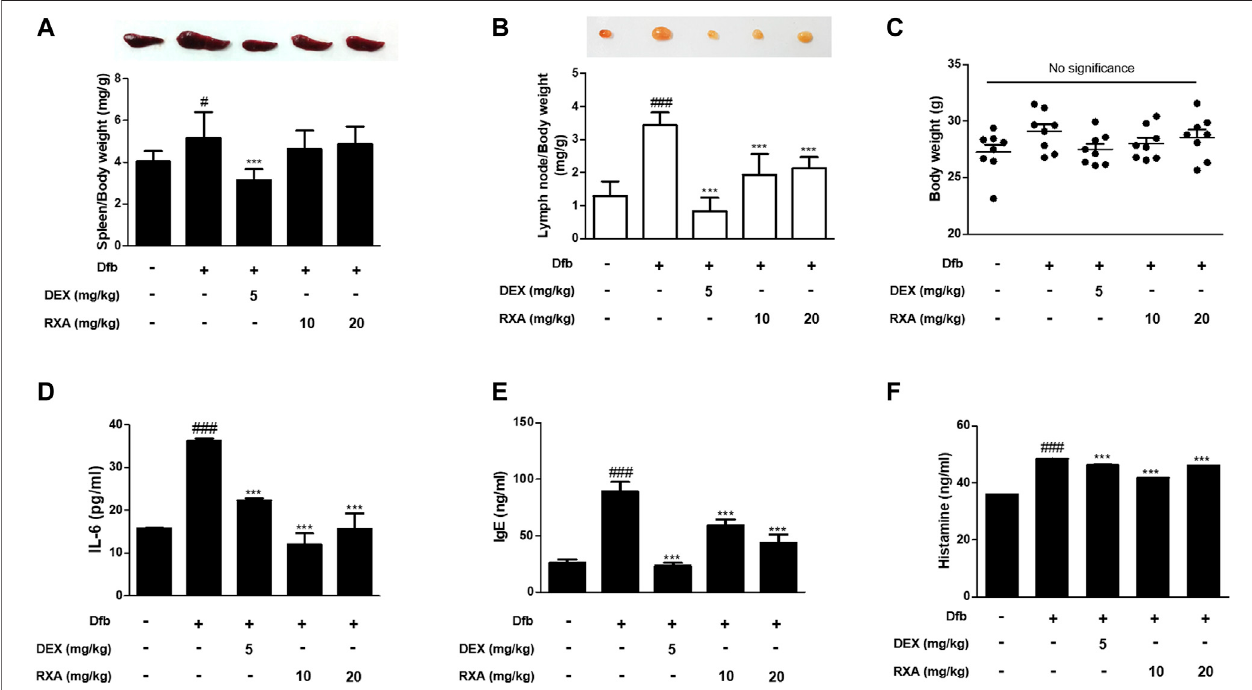
FIGURE 2 | Effects of RXA on the spleen, lymph node, and the production of mediators of AD in Dfb-induced NC/Nga mice. Representative size and weight of (A) spleen and (B) lymph node were compared by photographic images. Weights of organs and whole body were measured. (C) Body weights at the end of 8 weeks of experimentation. The production of (D) pro-in fl ammatory cytokines, (E) serum IgE, and (F) histamine release were measured by ELISA. The data shown represent mean ± S.D. of three independent experiments ( n (cid:1) 8). # p < 0.05, ### p < 0.001 vs. the control group; *** p < 0.001 vs. Dfb-treated group. Dfb, Dermatophagoides farinae